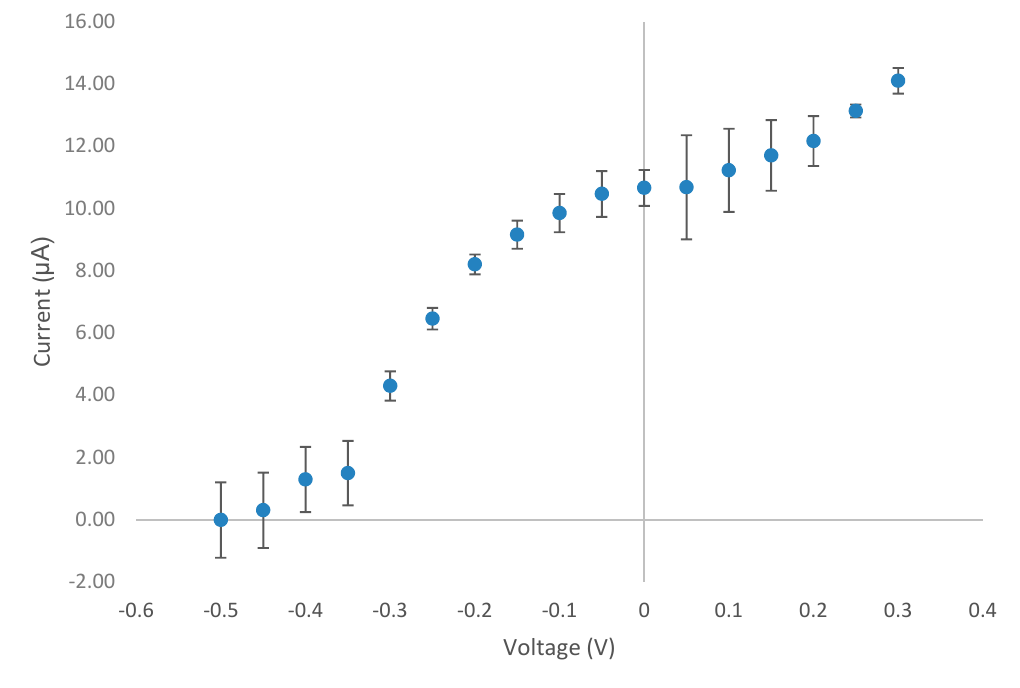
Figure 5. Hydrodynamic voltammogram obtained for vitamin B1 using the CoPC-SPCE sensor using the same buffer conditions as mentioned previously in Figure 2. Table 3. Selection of water-soluble vitamins and additives present in food supplements, which were examined as potential